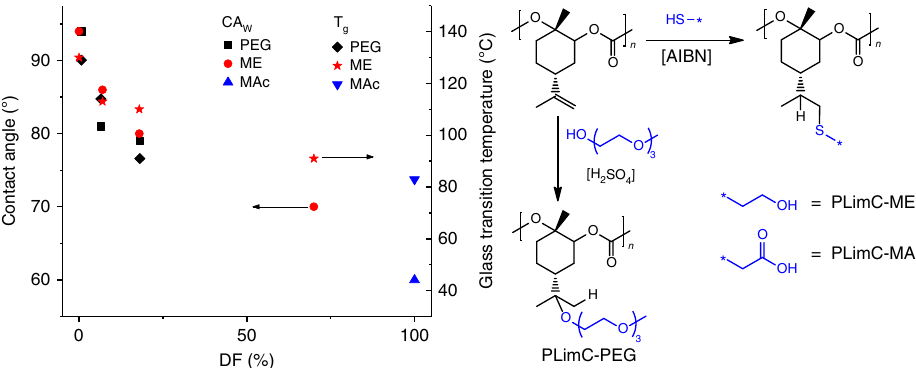
Figure 5 | The transformation into hydrophilic/water-soluble PLimC. Dependency of contact angle to water and T g of a PLimC film on the degree of functionalization with PEG-3-OH (black), ME (red) or MAc (blue), respectively. The schematic of the functionalization is shown for the thiol-ene addition of ME and MAc to give PLimC-ME and PLimC-MAc, respectively, and the electrophilic addition of PEG-3-OH to give PLimC-PEG.